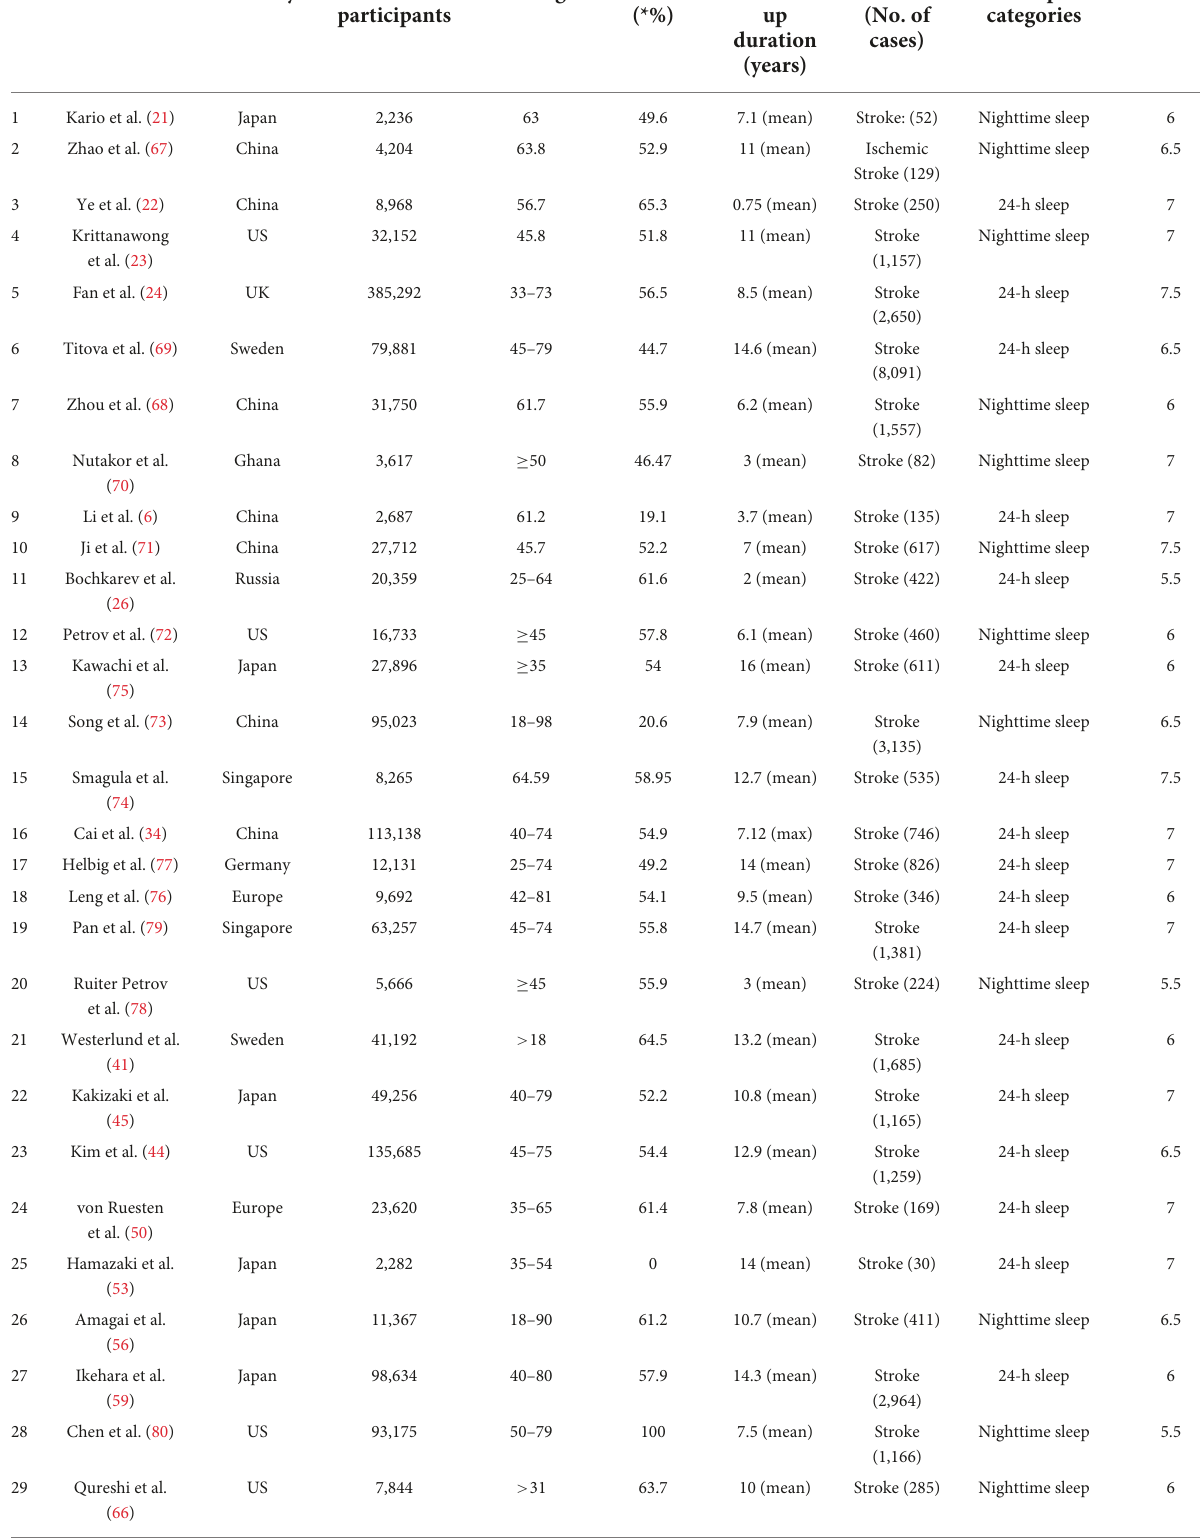
TABLE 2 Characteristics of 29 studies about cerebrovascular diseases included in the